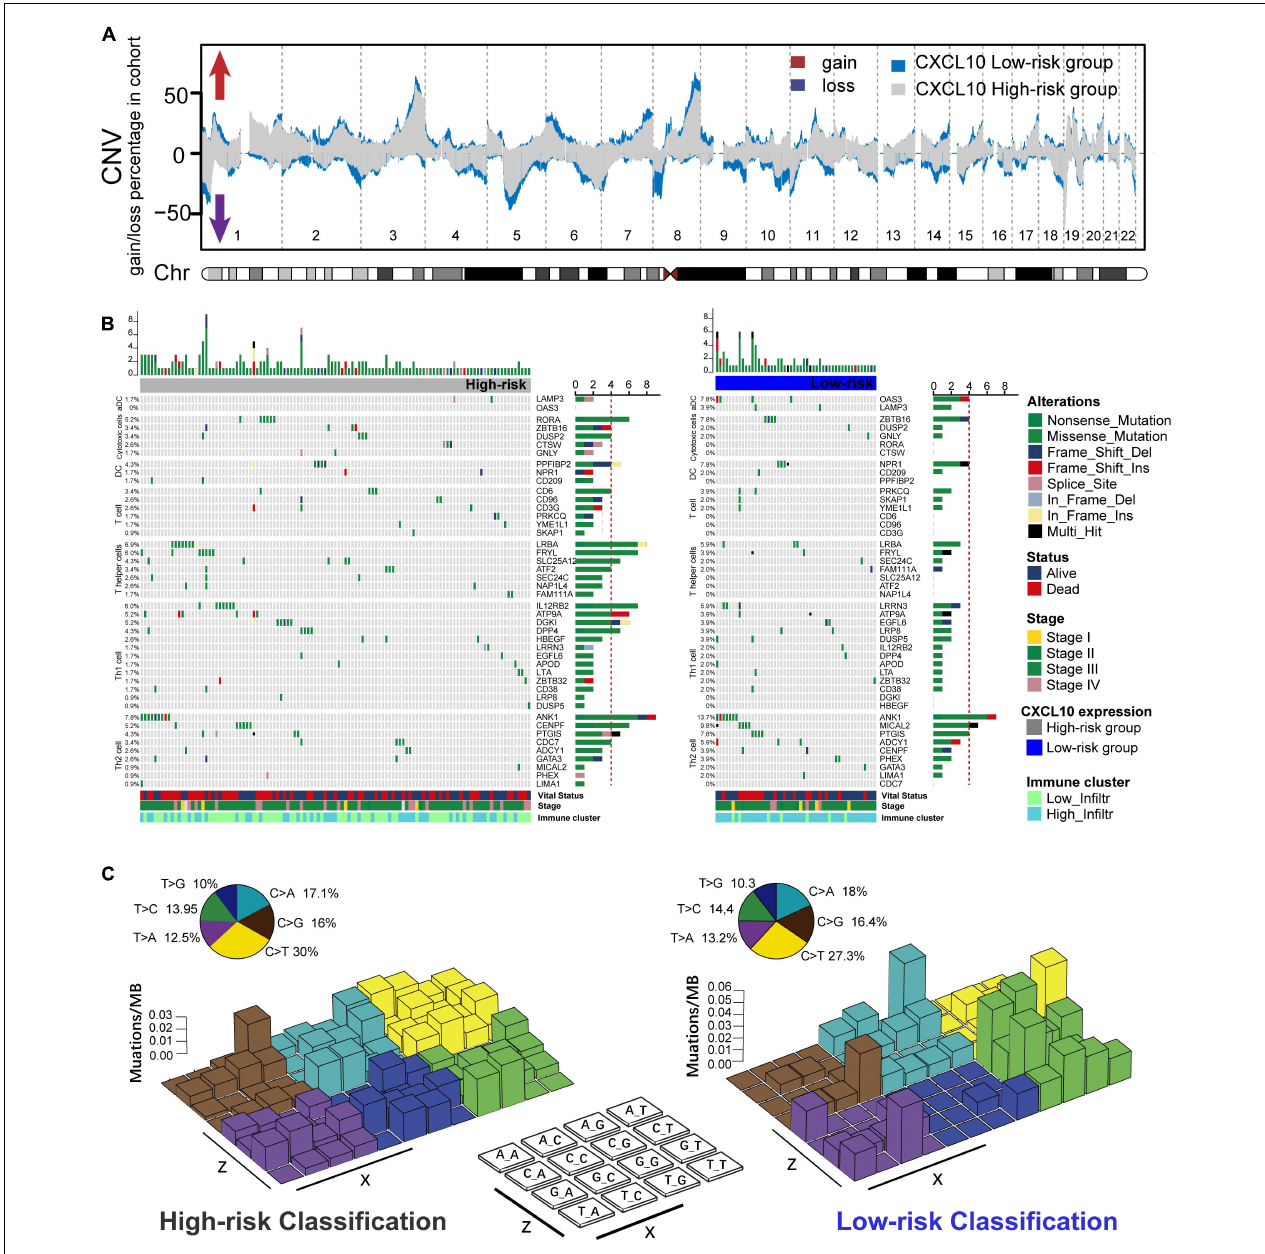
FIGURE 4 | Genetic alteration extracted from the aggregated ovarian cancer samples. (A) The Copy number profiles of high (blue)- and low (gray)-risk classification showed different pattern of gains and losses. Frequency of copy number alterations were plotted on Y-axis, and corresponding chromosome was plotted on X-axis (chr 1–22). (B) Mutational landscape of specific immune-cell genetic alterations in high-risk classification (left) and low risk classification (right). The middle panel depicted 45 valid signature genes alteration across analyzed TCGA dataset, and different alteration types were coded with different color. The number on the right indicated the mutation frequency of each gene. The right panel indicated the proportion of each variant type. Each column represented individual patients, and displayed with survival status, stages, and immune cluster. (C) Legoplot representation of mutation patterns in two classifications. Single-nucleotide substitutions are divided into six categories with 16 surrounding flanking bases (each category represented by a different color). Inset pie showed the proportion of six categories of mutation